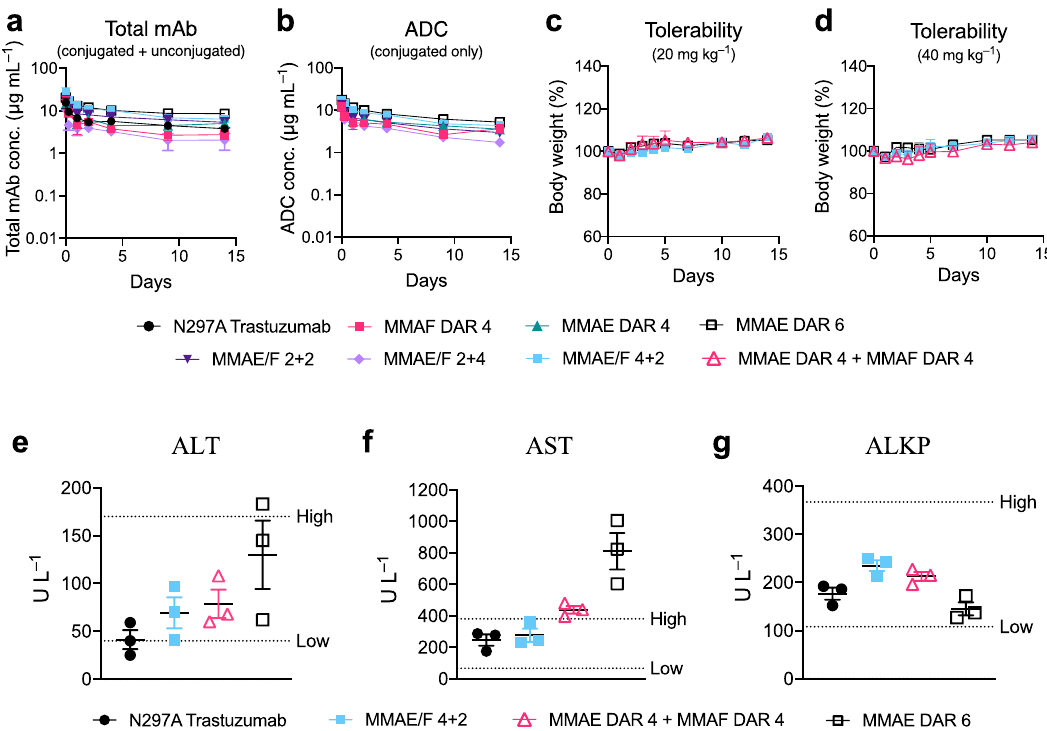
Fig. 4 In vivo pharmacokinetics (PK), tolerability, and blood chemistry. a , b PK of unmodi fi ed N297A Trastuzumab (black circle), MMAF DAR 4 ADC (magenta square), MMAE DAR 4 ADC (green triangle), MMAE DAR 6 ADC (black open square), MMAE/F 2 + 2 ADC (dark purple inverted triangle), MMAE/F 2 + 4 ADC (light purple diamond), and MMAE/F 4 + 2 ADC (cyan square) in female CD-1 mice ( n = 3 for MMAE DAR 4 ADC; n = 4 for other groups). At the indicated time points, blood was collected to quantify total antibody (conjugated and unconjugated, a ) and ADC (conjugated only, b ) by sandwich ELISA. c , d Body weight change after female BALB/c mice ( n = 3) were administered with a single dose of MMAE DAR 6 ADC, MMAE/F 4 + 2 ADC, or a 1 : 1 mixture of MMAF DAR 4 and MMAE DAR 4 ADCs (magenta open triangle) at 20 ( c ) or 40 mg kg − 1 ( d ). No mice showed acute symptoms or reached the pre-de fi ned humane endpoint during 2-week monitoring. e – g Blood chemistry parameters (ALT ( e ), AST ( f ), and ALKP ( g )) 15 days post injection of a single dose of vehicle control, MMAE/F 4 + 2 ADC (40 mg mL − 1 ), a 1 : 1 mixture of MMAE DAR 4 and MMAF DAR 4 ADCs (40 mg mL − 1 each), or MMAE DAR 6 ADC (40 mg mL − 1 ) in female BALB/c mice ( n = 3). Dotted lines (High and Low) represent 95% con fi dential interval of each parameter in healthy BALB/c mice (data from Charles River Laboratories). Data are presented as mean values ± SEM. Source data are available as a Source Data fi le.